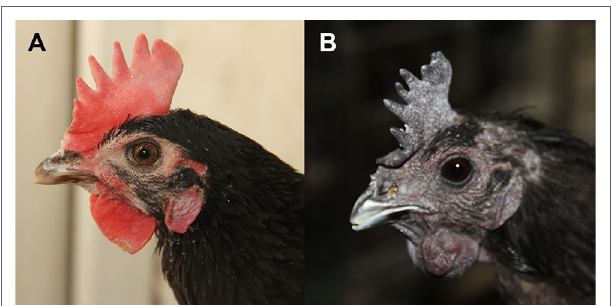
FIGURE 1 | Comb color phenotype in Dongxiang blue-shelled chicken. (A) Chicken comb with typical red color. (B) Dark chicken comb, the wattle, face, and ear lobe also present fibromelanosis